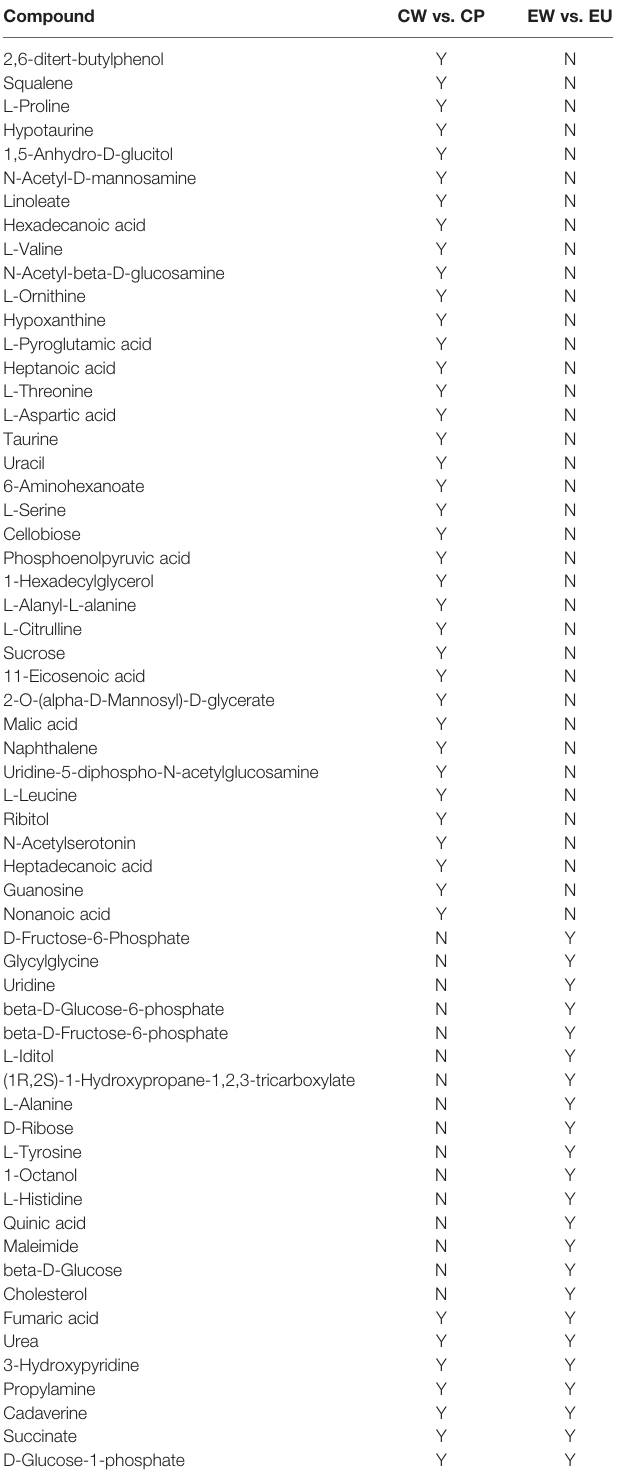
TABLE 4 | Differential metabolites in the Venn diagram of EW vs. EU and CW vs. CP groups